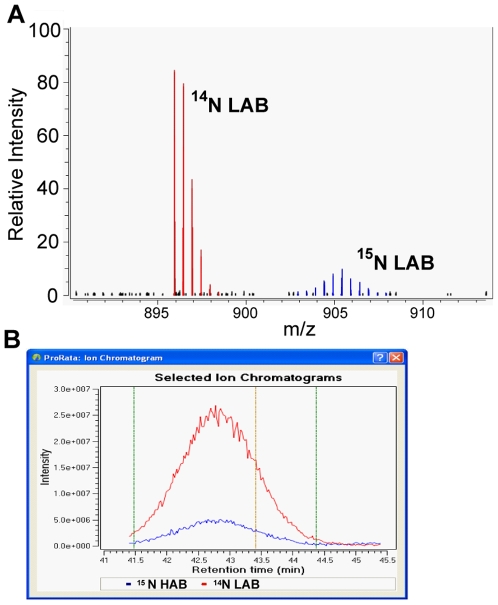
Analysis of expression differences by MS analysis.
A) ESI mass spectrum of the 14N LAB (red) and 15N HAB (blue) isotope forms of the GLO1 peptide GFGHIGIAVPDVYSACK in cerebellar tissue. The isotopologue patterns of the 14N and 15N peptide signals (m/z) were used for relative quantification with ProRata. B) Extracted ion chromatograms for the GLO1 peptide, extracted from A, showing an upregulation of GLO1 in LAB mice. No smoothing was applied.